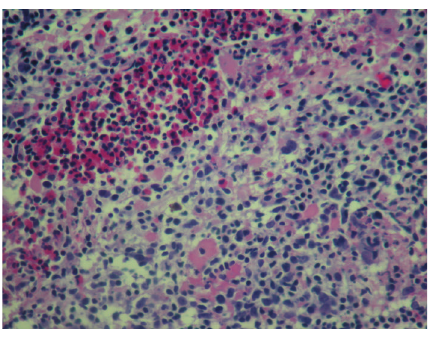
Figure 6: Histology.